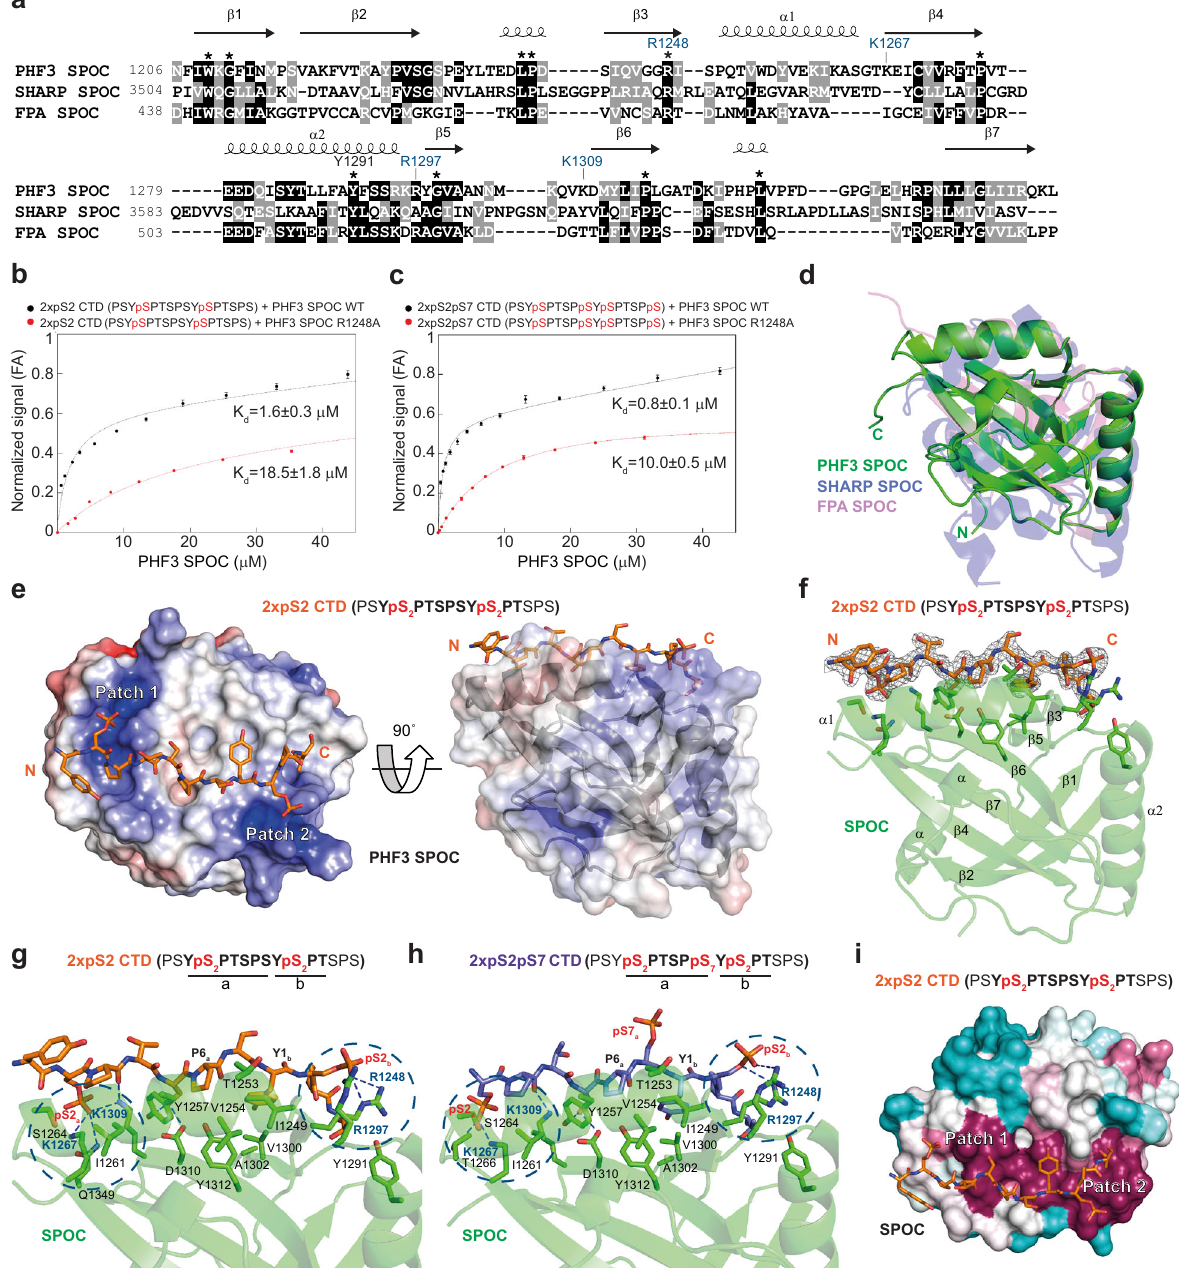
Fig. 2 PHF3 SPOC binds pS2 CTD peptides in vitro. a Structure-based alignment of SPOC domains from PHF3 (6Q2V), SHARP (2RT5), and FPA (5KXF). Conserved residues are marked with an asterisk. b , c Fluorescence anisotropy (FA) measurement of the binding of b , 2xpS2 and c , 2xpS2pS7 FAM-labeled CTD peptides to PHF3 SPOC WT or R1248A mutant. Normalized fl uorescence anisotropy is plotted as a function of protein concentration ( n = 3). The data were normalized for visualization purposes and the experimental isotherms were fi tted to one site saturation with non-speci fi c binding model. d Overlay of SPOC structures from PHF3 (6Q2V), SHARP (2RT5) and FPA (5KXF) showed an average RMSD of 2.75 Å over 149 aligned C α atoms between PHF3 and SHARP SPOC, and average RMSD of 1.94 Å over 123 aligned C α atoms between PHF3 and FPA SPOC. e 2xpS2 CTD peptide binds two positively charged patches (Patch 1 and 2) on the surface of PHF3 SPOC. The color coded electrostatic surface potential of SPOC was drawn using the Adaptive Poisson- Boltzmann Solver package within PyMol. The electrostatic potential ranges from − 5 (red) to + 5 (blue) kT/e. The N- and C-termini of the peptide are indicated and always shown in the same orientation. f 2 F o − F c electron density map of pS2 peptide contoured at the 1.5 σ level. CTD peptide sequences used for X-ray structures correspond to those used in binding assays. The residues of the CTD diheptapeptide that are visible in the structure are indicated in bold. CTD peptides used for X-ray structures had the same sequence as for the binding assays but were not fl uorescently labeled. g , h Hydrogen bonding interactions between g , 2xpS2 and h , 2xpS2pS7 CTD peptides and PHF3 SPOC. SPOC monomer binds two phosphorylated S2 groups on the CTD peptides. SPOC residue labels from two positively charged patches are colored blue and the patches are contoured with dashed circles. i Evolutionary conservation of PHF3 SPOC residues projected onto the 2xpS2 co-structure using the ConSurf server. Residues are colored by their conservation grades with maroon showing the highest and turquoise the lowest degree of conservation. Two positively charged patches (Patch 1 and 2) are